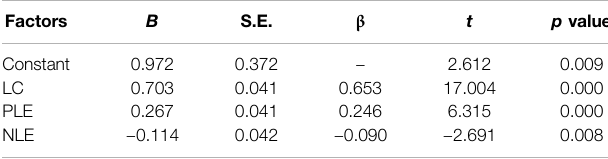
TABLE 12 | Factors included in the fi nal multiple regression